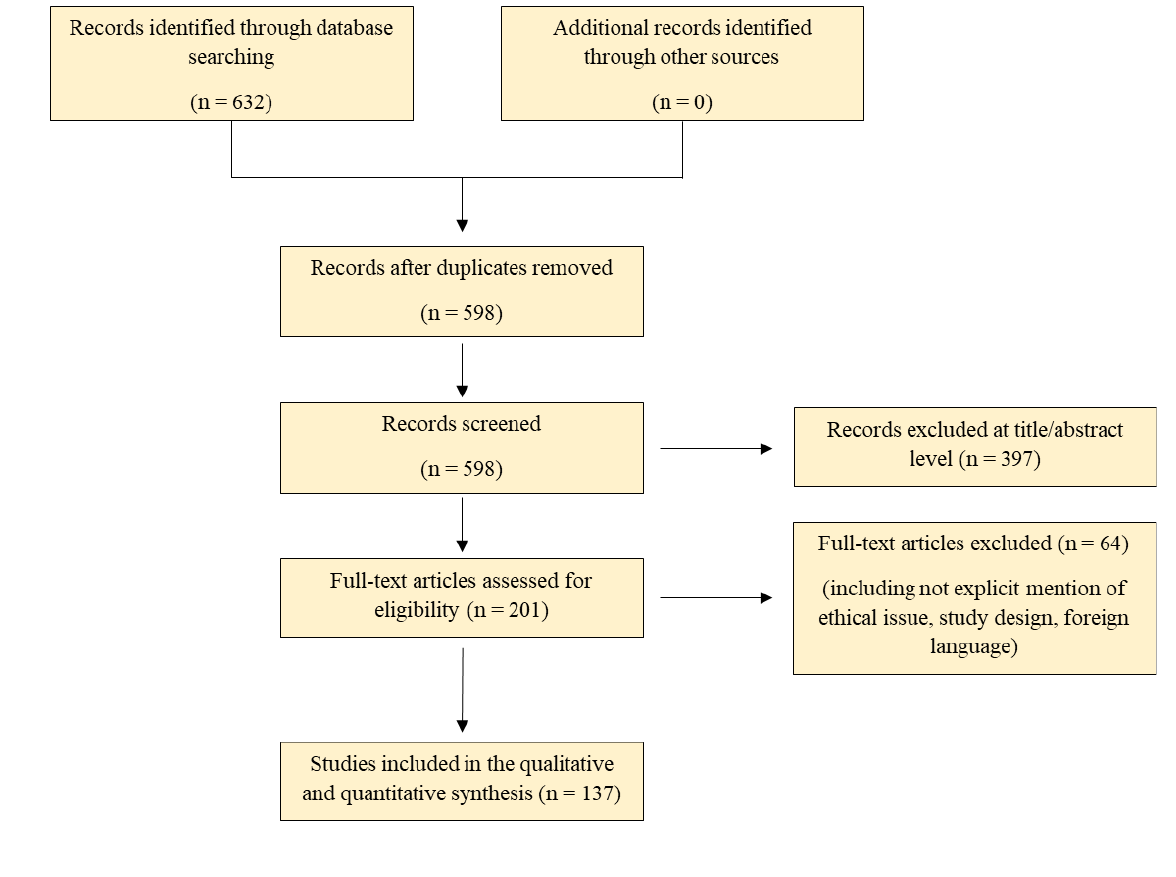
Figure 1. Our review strategy following PRISMA standards.